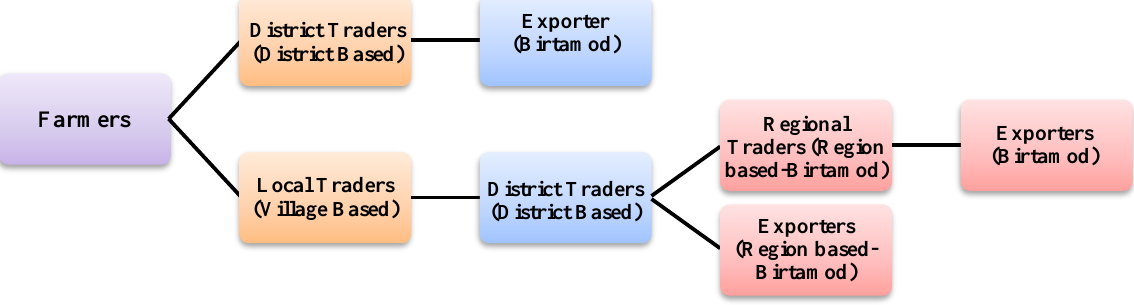
Figure 3 Marketing Channels of large cardamom in the study area